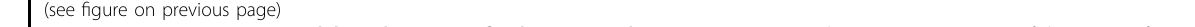
Fig. 1 Breast cancer patients exhibit subtype-speci fi c alternative splicing (AS) events. A Schematic representation of the strategy for identifying alternatively spliced (AS) events in breast cancer subtypes (TCGA-BRCA dataset). B Number of AS events caused by differential usage of cassette exons (CE) or by intron retention (IR) for Luminal A, Luminal B, HER2 + , and Basal breast cancer subtypes, and total number of genes that they correspond to. Statistical test Irwin – Hall p -value summarization was used on individual splicing events. Details of samples for each subtype are in Data set 1 in supplementary information. C , D Distribution of number of genes undergoing different number of CE ( C ) and IR events ( D ) predicted for Luminal A, Luminal B, HER2 + , and Basal subtypes. E – H Quantitative real-time-PCR (qRT-PCR) validation in MCF-10A (untransformed mammary epithelial-derived), and representative subtype-speci fi c cancer cell lines like BT-474 (Luminal B), MDA-MB-231 (Basal), and MDA-MB-453 (HER2 + ) for CE event in TOP1 ( E , F ) predicted for Luminal B and HER2 + subtypes; and for CE event in RHOA ( G , H ) predicted for Basal subtype. Normalized transcript level for protein-coding (PC) and alternatively spliced (AS) isoforms of TOP1 and RHOA gene for each cell line (mean± SD, n = 4) show differential expression of the isoforms. A pictorial representation of exon/intron positions and primer sites are also shown. Data in ( E – H ) were analyzed by